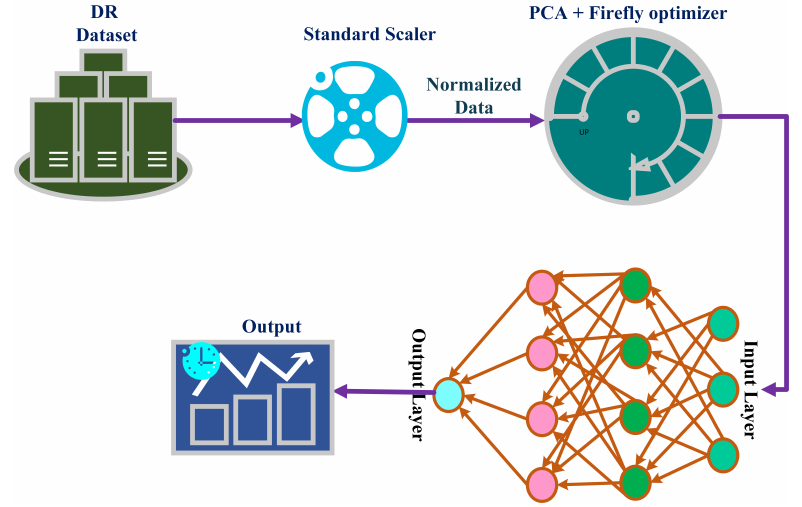
Figure 1. DNN-PCA Model for Diabetic